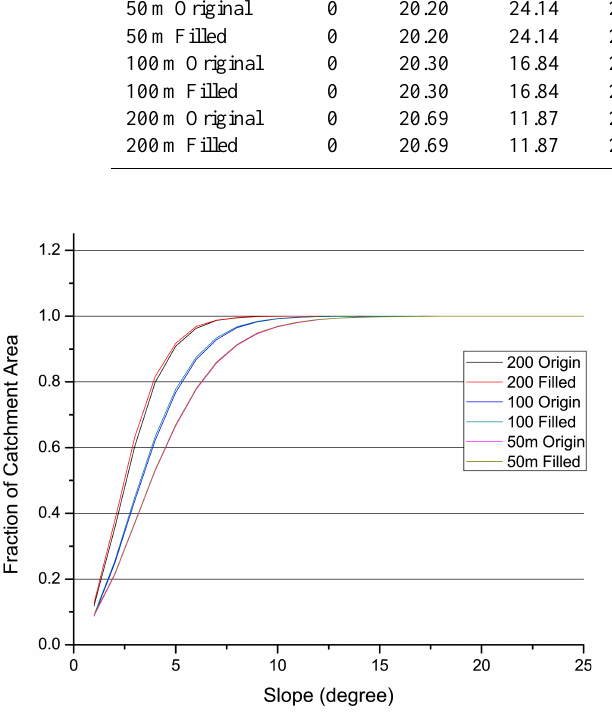
Fig. 7. Cumulative distributions of DEM slopes.